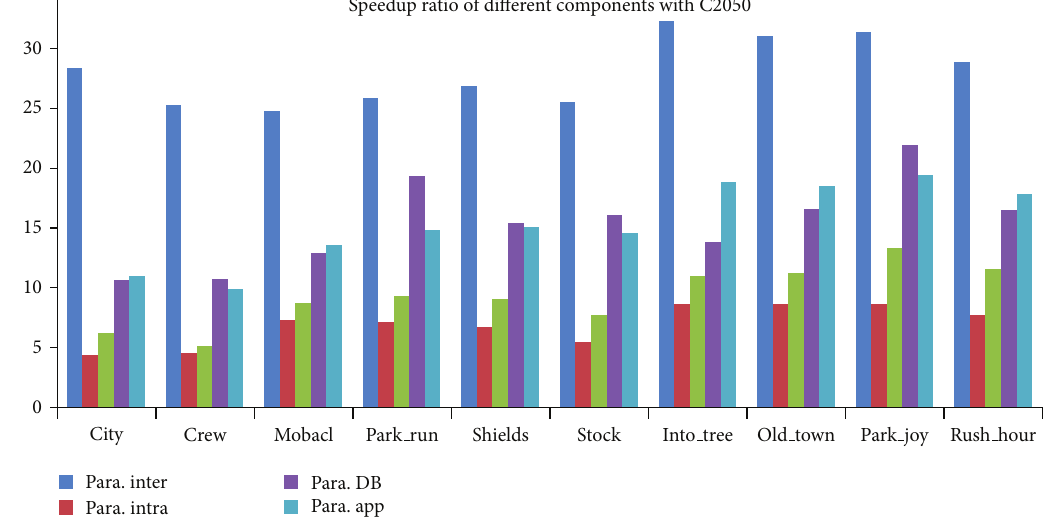
Figure 18: Speedup ratio of the proposed parallel H.264 encoder on